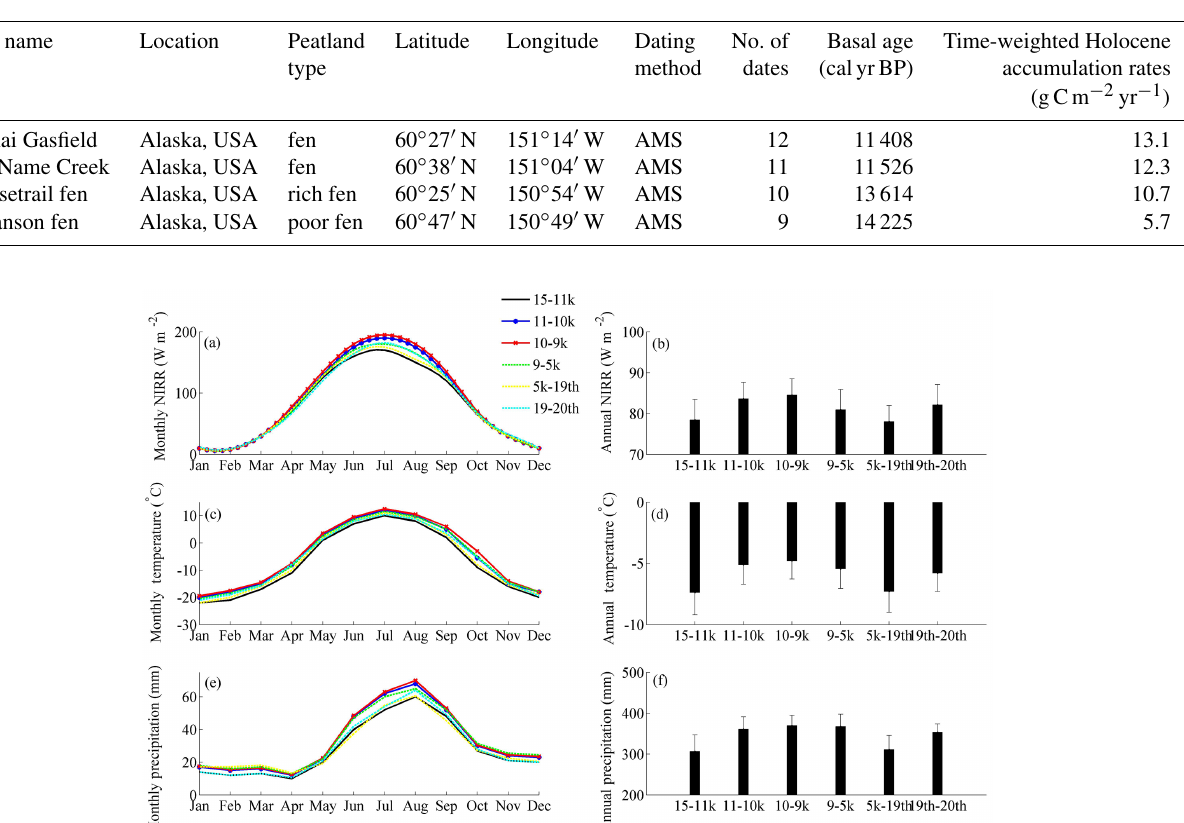
Table 5. Sites used for comparison of carbon accumulation rates between simulation and observation (Jones and Yu, 2010).